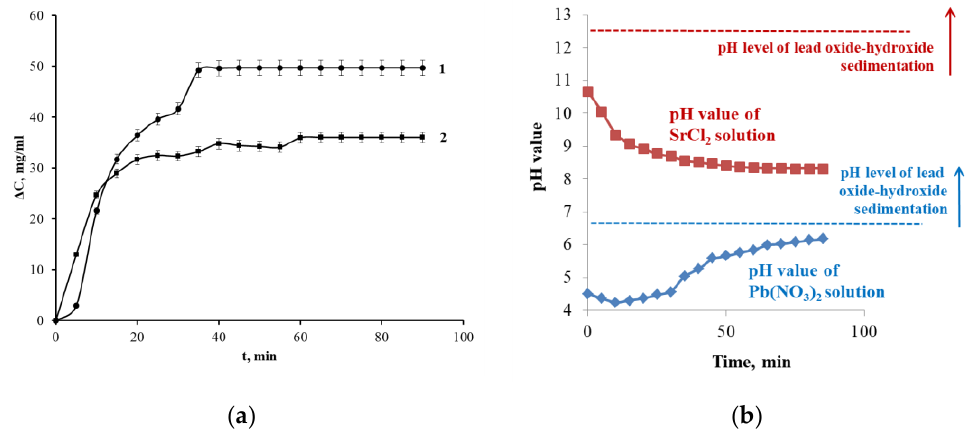
Figure 3. Sorption kinetic curve of Pb 2 + (1) and Sr 2 + (2) ions on PPT at pH < 6.5 and pH > 8.5, respectively ( a ), and the pH value during the Pb 2 + and Sr 2 + sorption on PPT ( b ).